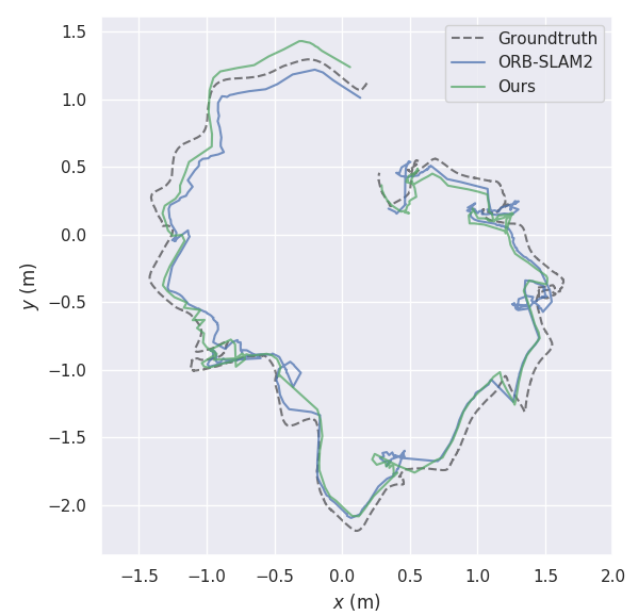
Figure 9. The comparison of the trajectories for ground truth, ORB-SLAM2, and our method on dataset